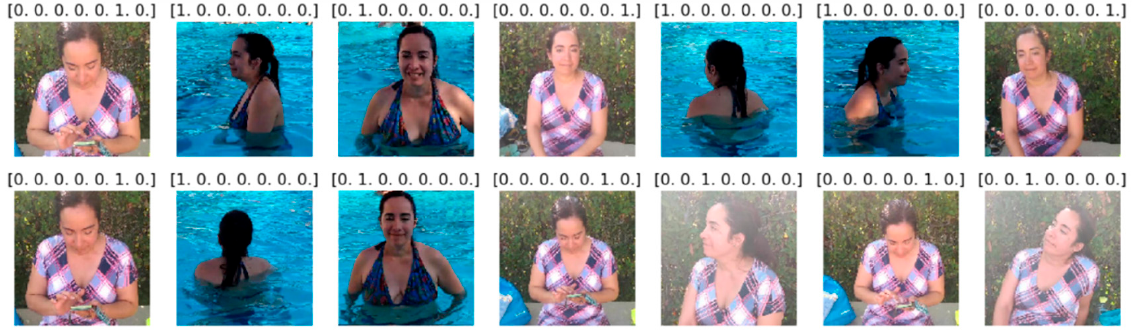
Figure 10. Image set of each category with their respective testing labels.